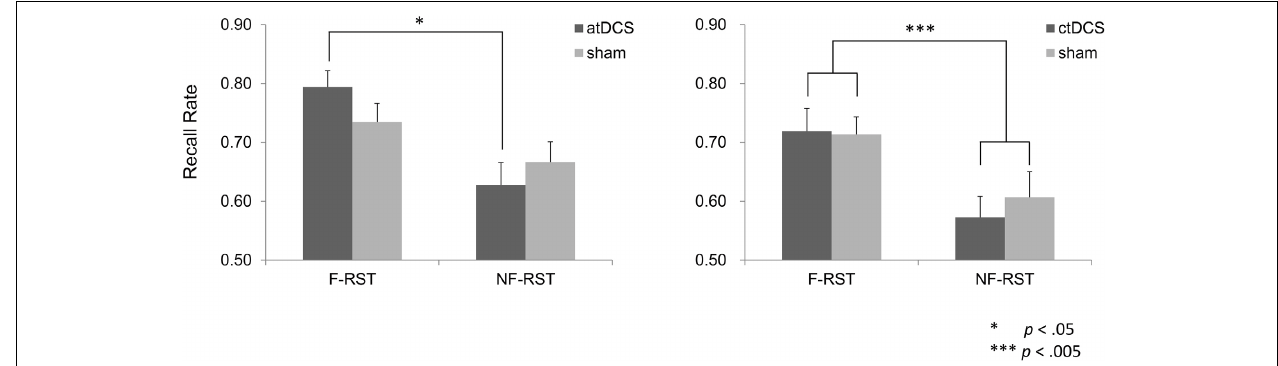
FIGURE 4 | Number of intrusion errors in the focus and non-focus conditions. In both the atDCS and ctDCS groups, more intrusion errors were observed in the non-focus condition than the focus condition. However, brain stimulation did not modulate those errors.